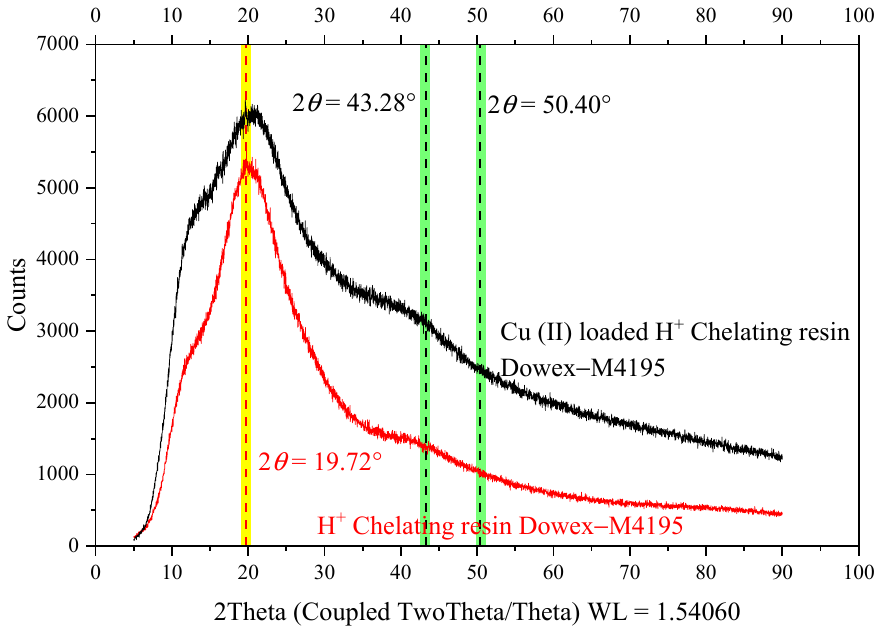
10 of 24 Figure 9. FTIR spectrum before and after Cu(II) was loaded onto H + Dowex-M4195 chelating resin. 2.8. Crystal Structure before and after Ion Exchange Study of the H + Dowex-M4195 Chelating Resin The crystal structure before and after the ion exchange process of the resin was in- vestigated using X-ray powder diffraction by measuring the intensity of radiation re- flected at various angles from 5 0 < 2 θ < 90 0 with registering of Cu K α at 1.54060 as shown in Figure 10. The maximum diffraction peaks were observed at 2 θ = 19.72 0 , which is the same as reported in the literature [40]. The figure shows that the intensity of the peak detected for Cu(II) loaded onto H + Dowex-M4195 chelating resin was higher than that for